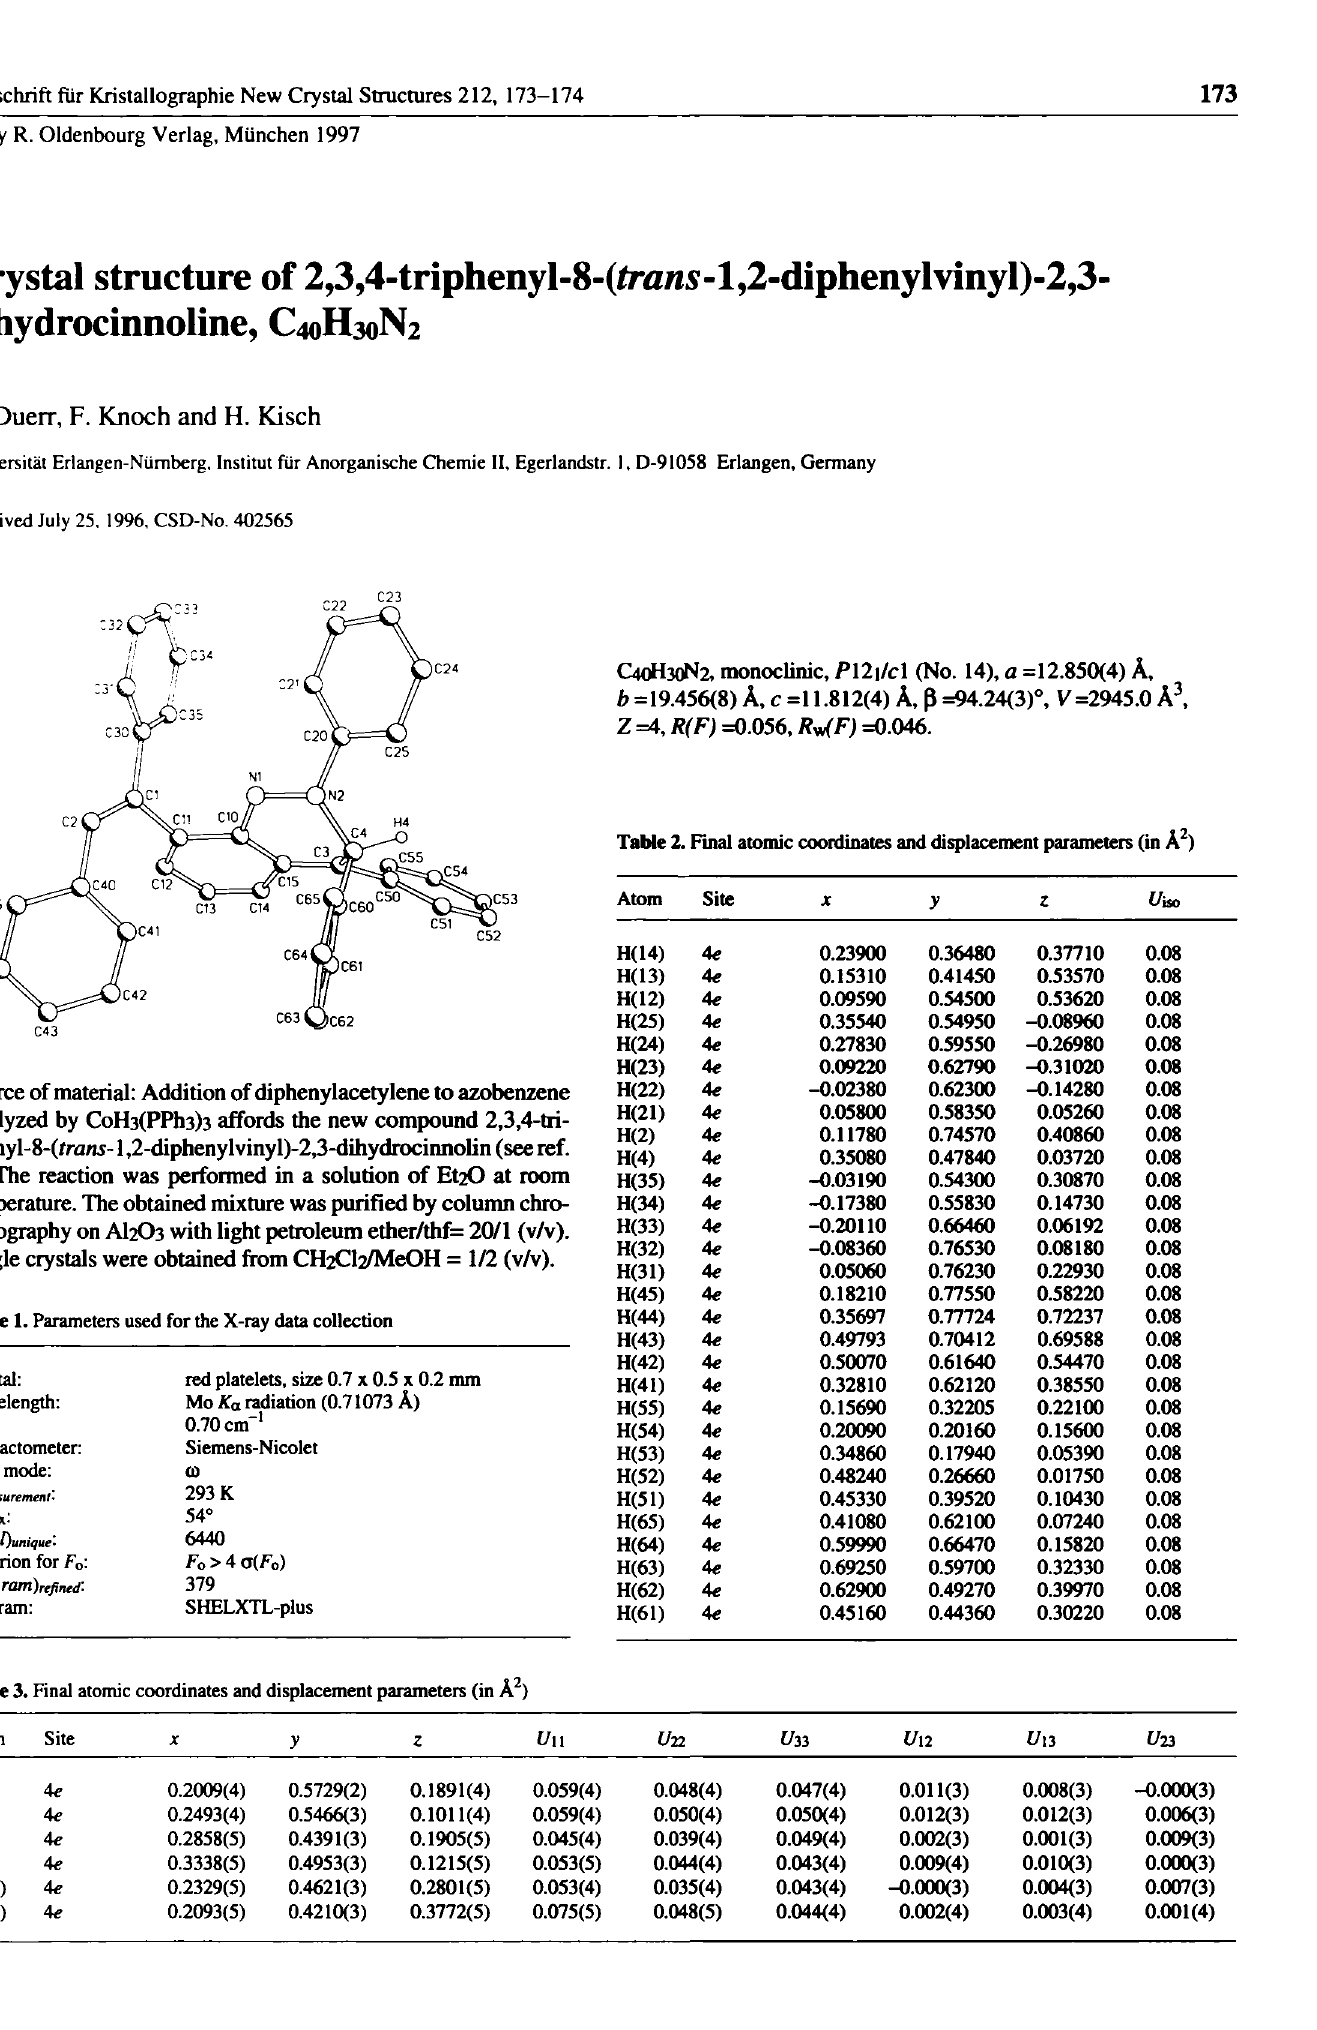
Table 3. Final atomic coordinates and displacement parameters (in Â 2